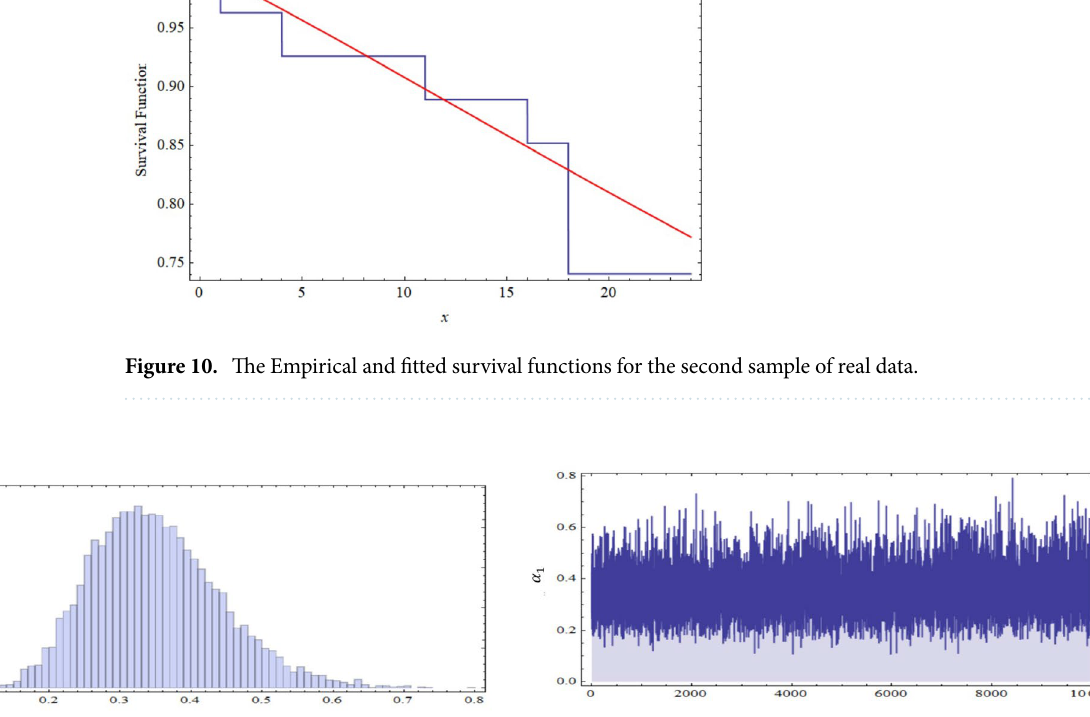
Figure 11. The posterior density function and the trace plots for the parameters α 1